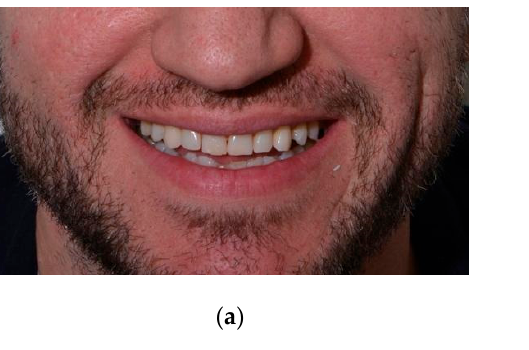
Figure 9. Intra-oral smile view before ( a ) and after ( b ) teeth alignment.